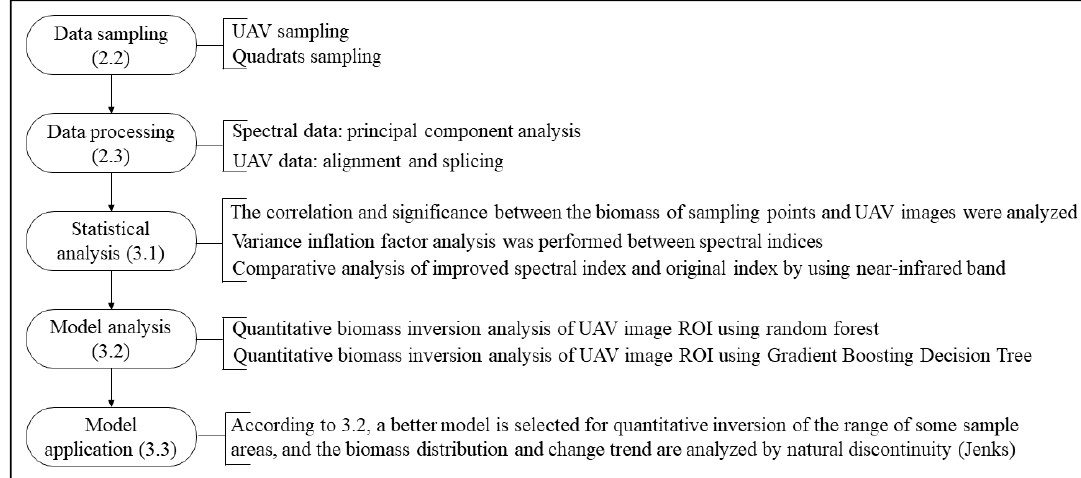
Figure 1. Methodological scheme. The figures in () are the corresponding chapters in this paper.